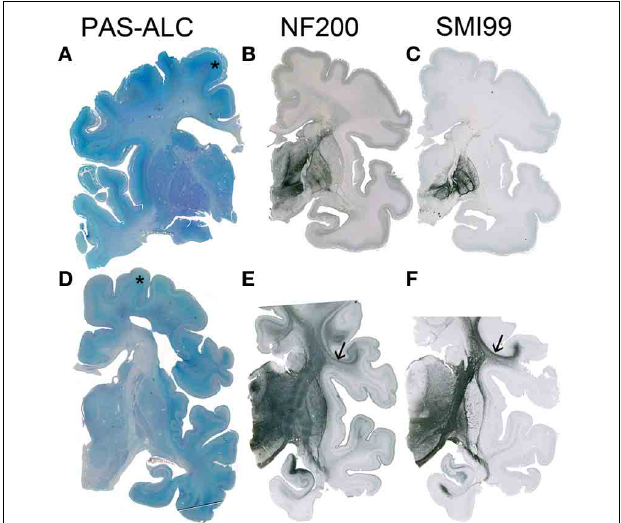
FIGURE 3 | Although the resolution of the subplate zone starts after 34 PCW, the subplate remains visible as a major component of the telecephalic wall (asterisk in A,D). In the human telencephalon, cortico-cortical connections are still not developed (B) or myelinated (C) at 33PCW, while at 40PCW substantial development and myelination of cortico-cortical fiber can be observed (arrow in E,F ). A–C 34PCW, D–F 40PCW.